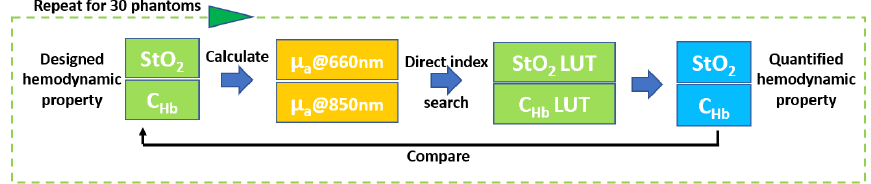
Figure 3. Flowchart of in silico quantification and validation of 30 digital phantoms .